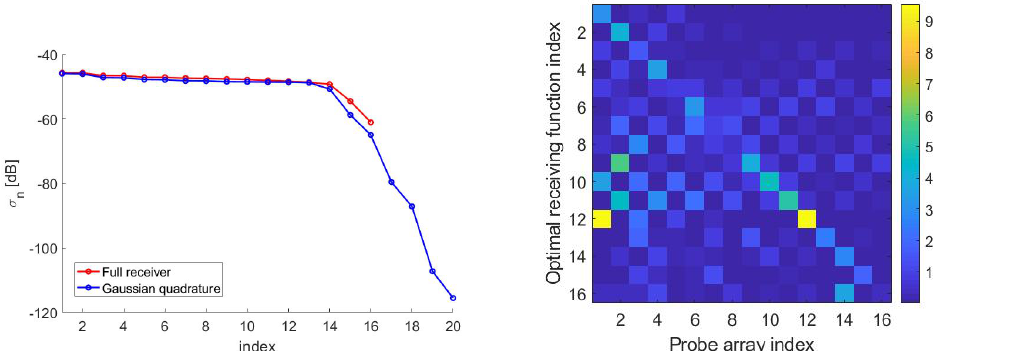
Figure 10. ( Left ): SVB for the case when “optimal virtual” sensing functions are used, instead of the PSWFs, to form the link matrix and the SVB obtained for the case of point-like elements and use of the “optimal” weights. ( Right ): percentage errors when the point-like elements when the “optimal” weights are used to form the elements of the link matrix instead of the “optimal virtual” sensors. The rows span the different sets of weights while the columns the possible impinging fields.